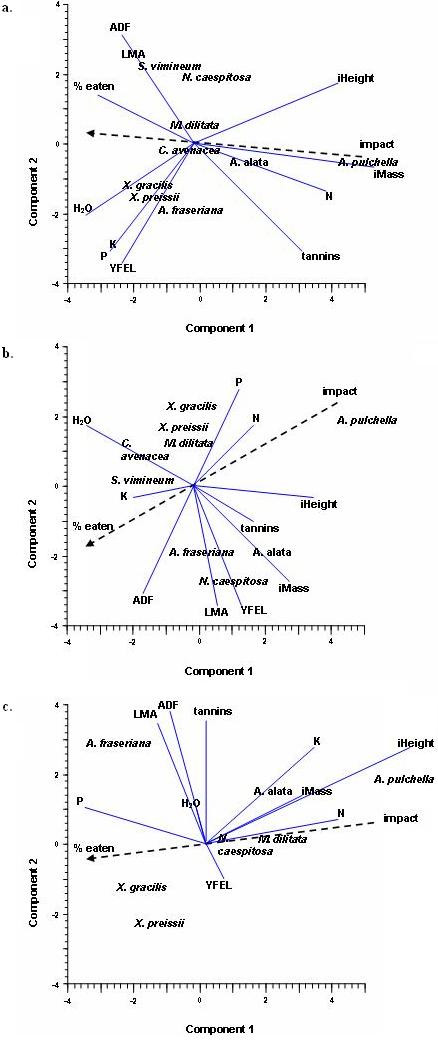
Macropod raw scat counts at 3 locations, 2002. First count taken after establishment, final counts taken before harvest. Solid fill represents January-February count, diagonal fill is August-September. Letters refer to Scheffé post-hoc test. Rabbit scats were rare.